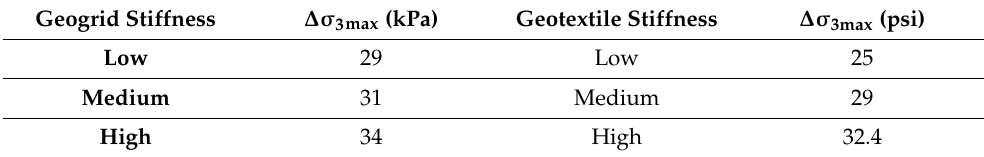
Table 5. Maximum lateral confining stress for geosynthetics with varying levels of stiffness.